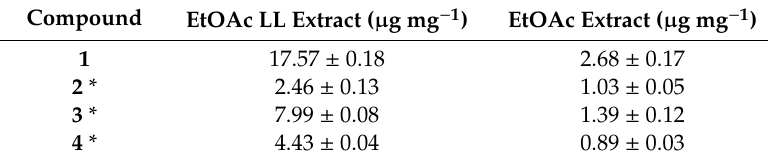
Table 1. Quantification results of compound 1 - 4 in EtOAc and EtOAc-LL extracts of